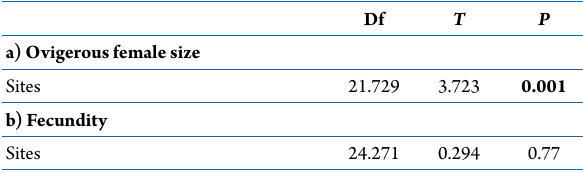
Table 5. ( a ) Student T-test results for comparison of size of ovigerous females of Sunamphitoe pelagica and ( b ) Student T-test results for comparison of fecundity of S. pelagica .